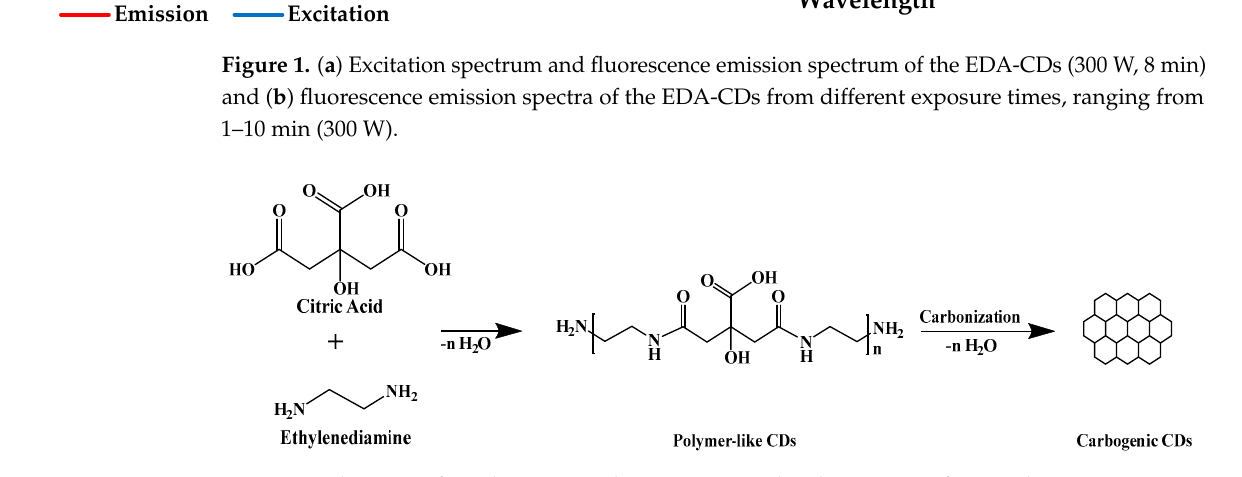
Figure 2. Schematic of condensation polymerization and carbonization of CA and EDA.